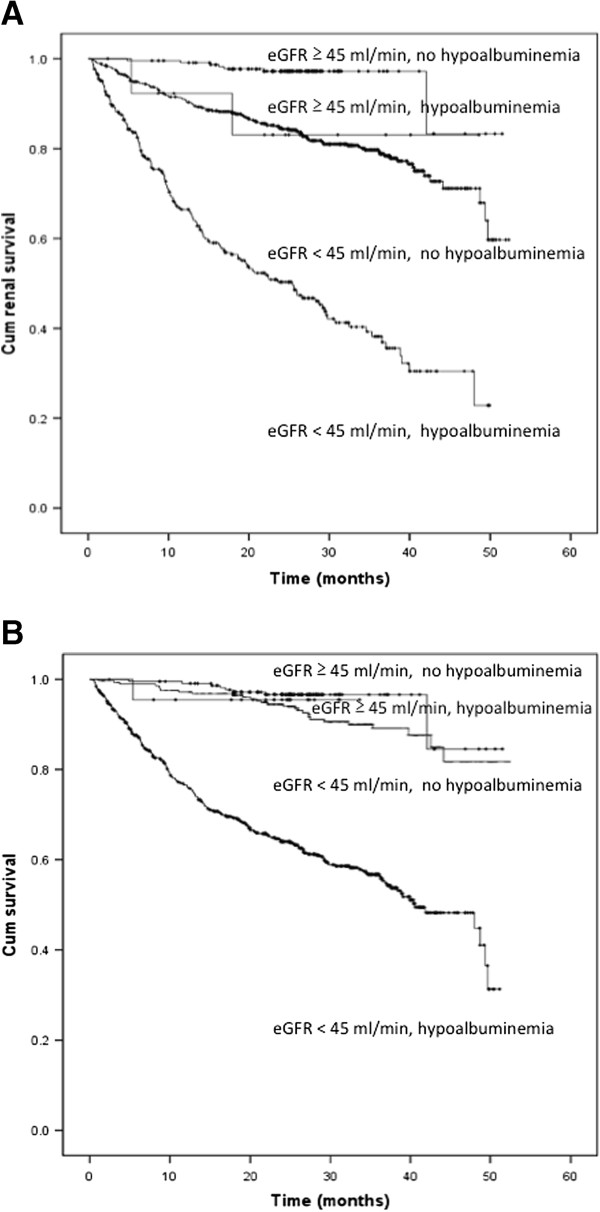
Cumulative renal survival (A) and overall survival (B) based on hypoalbuminemia in patients with eGFR above or below 45 mL/min per 1.73 m2 (log-rank test, p < 0.001).